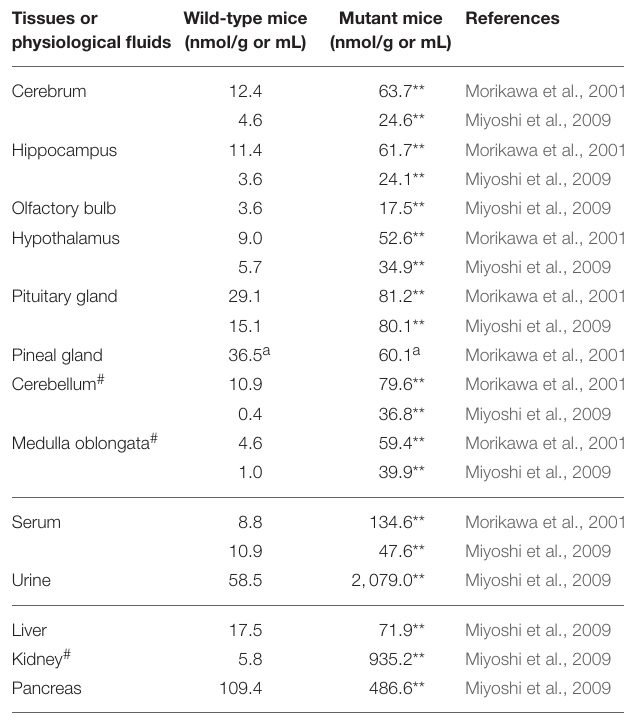
wild-type mice and mutant mice lacking DAO activity. Tissues or Wild-type mice physiological fluids (nmol/g or